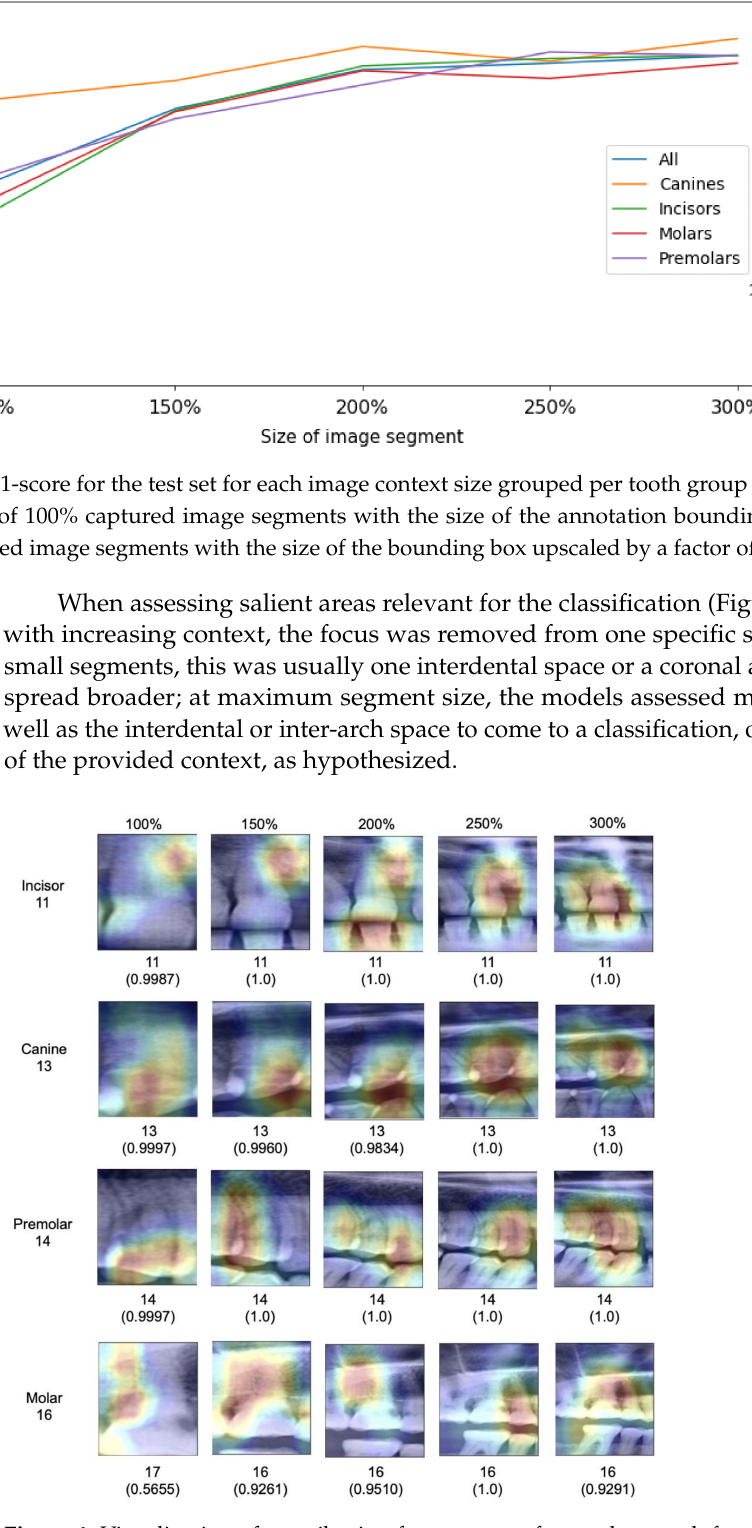
Figure 4. Visualization of contributing feature maps for random teeth from the test set. Images of incisors, canines, premolars and molars (lines) and different crop sizes (columns) are presented. The original images and the salient areas most relevant for the model’s decision (highlighted in yellow to red) are shown. Ground truth labels are shown on the left. Predicted labels and confidence scores (values closer to 1 indicate higher confidence in the model’s classification) are noted